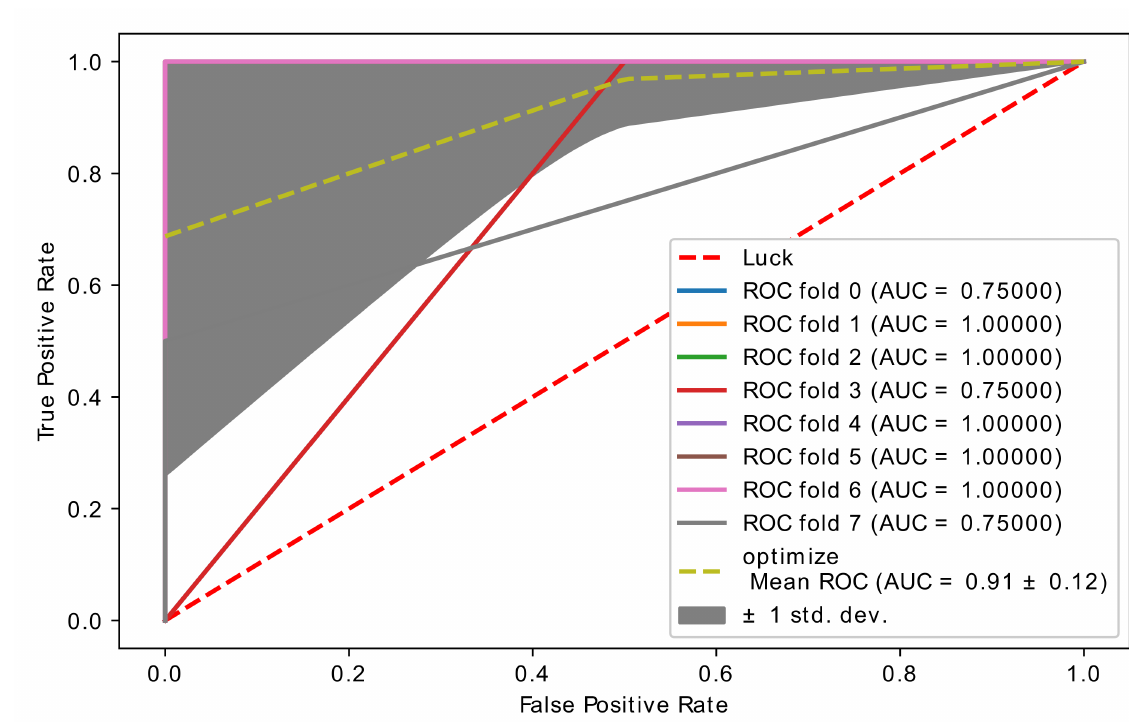
Figure 7. Accuracy curve obtained using the hybrid model with optimized CatBoost